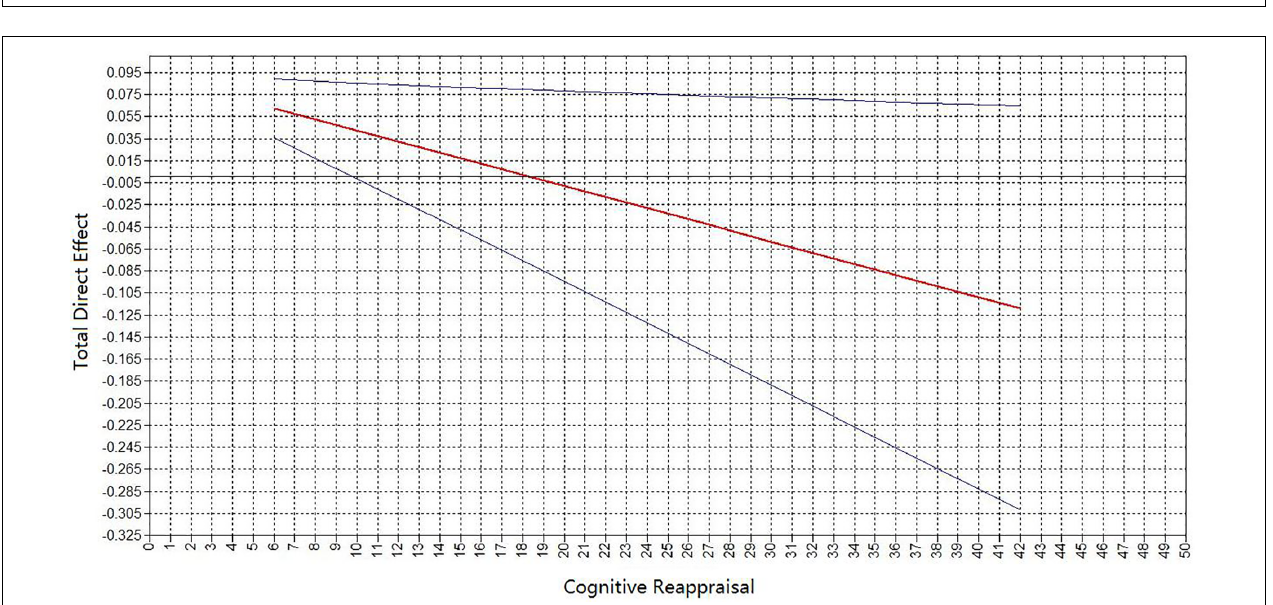
FIGURE 2 | Path analysis describing the associations between work stress, depressive symptoms, nicotine dependence, and cognitive reappraisal among fishermen with a smoking habit. The item parceling (dividing by item content) and cognitive reappraisal variable had three packs. Int = Work Stress ∗ Cognitive Reappraisal. Parameters are standardized. ∗∗ p < 0.01, ∗∗∗ p < 0.001.